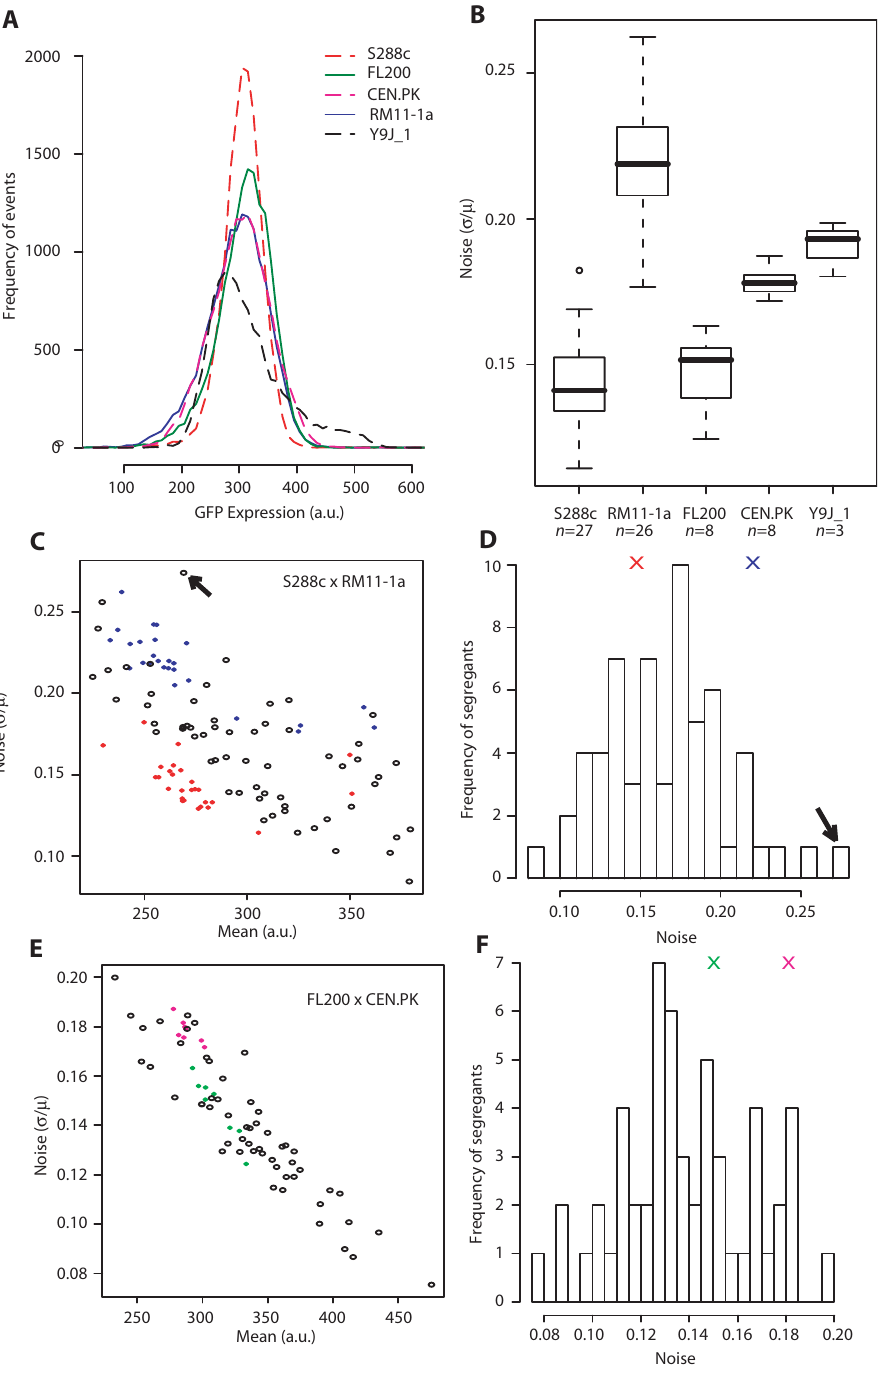
Figure 1. Strain-to-strain variation and complex genetic segregation of noise. A) Five representative flow-cytometry experiments on strains GY51, GY43, GY44, GY53 and GY445 derived from S288c, FL200, CEN.PK, RM11-1a and Y9J_1 respectively, each showing the distribution of P MET17 -GFP expression levels in 15,000 individual cells (events) after two hours of moderate induction. Raw fluorescent values were corrected for cell size and granularity as described in Materials and Methods. Mean expression levels were similar between strains, while variances differed. B) Boxplot representation of flow-cytometry experiments repeated n times in the same conditions as in A), showing reproducible noise differences between genetic backgrounds. C–D) Genetic segregation of P MET17 -GFP noise in a cross between S288c and RM11-1a backgrounds. Colored dots in C) represent independent flow-cytometry experiments performed on strain GY51 (red) or strain GY53 (blue). Each open circle represents the average values of three experiments performed on one S288c 6 RM11-1a segregant. The distribution of noise values in these segregants is shown in D), with the average noise of GY51 and GY53 represented as red and blue crosses, respectively. The arrow points to segregant GY157 displaying extremely high noise. E–F) Genetic segregation of P MET17 -GFP noise in a cross between FL200 and CEN.PK backgrounds. Representation is similar as in C) and D), with repeated experiments on strain GY43 and GY44 shown in green and magenta, respectively. One flow-cytometry experiment was performed on each segregant obtained by crossing GY43 and GY44 (open circles). All segregants analyzed possessed the ura3-52 mutation of GY44, and their differences must therefore result from allelic variations residing in other genes. doi:10.1371/journal.pgen.1000049.g001 PLoS Genetics |